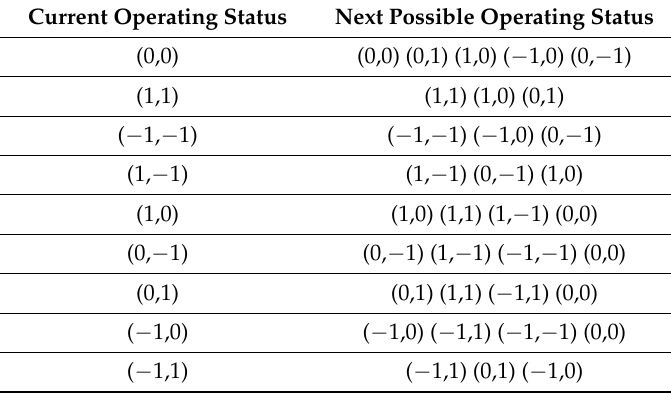
Table 3. Switching states allowed in proposed